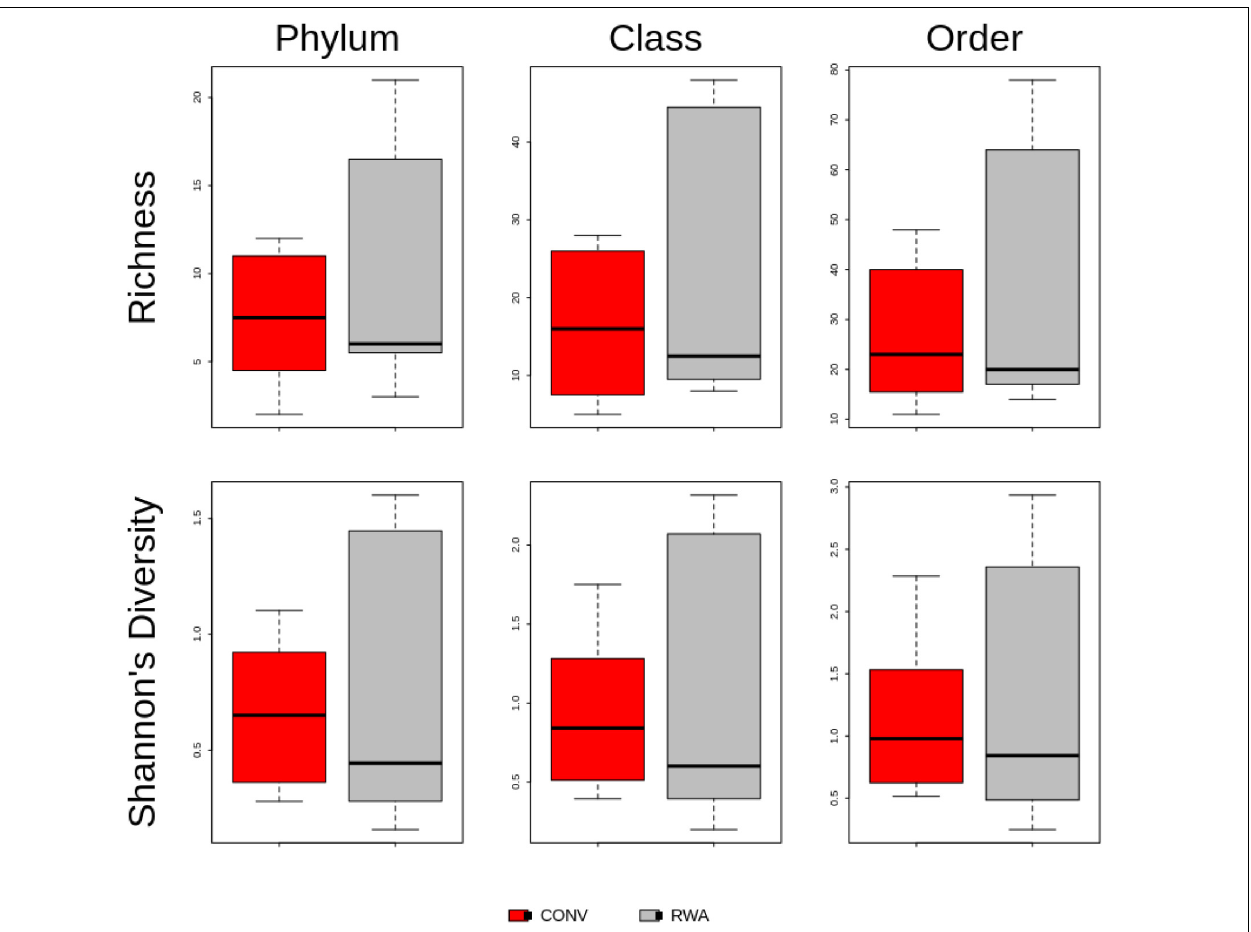
FIGURE 5 | Boxplot of resistome richness and Shannon’s diversity at the taxonomic phylum, class and order levels of the two study groups, CONV vs RWA. The horizontal line is the median value, the middle box indicates the inter-quantile range, whiskers represent values within 1.5 IQR of the lower and upper quartiles, and individual points show outlier